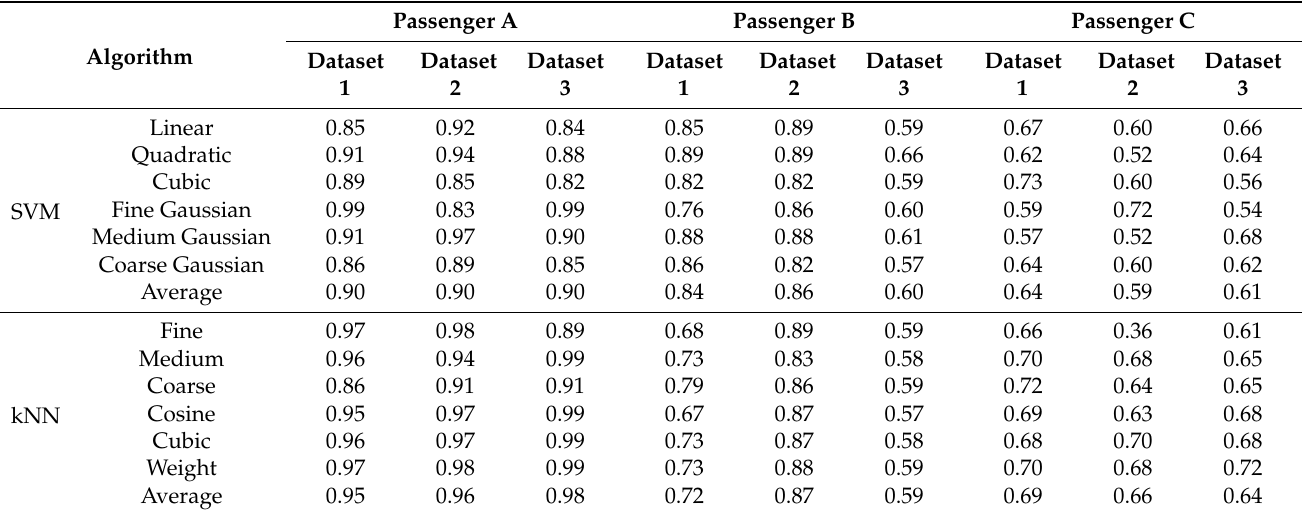
Table 6. Test AUC of all